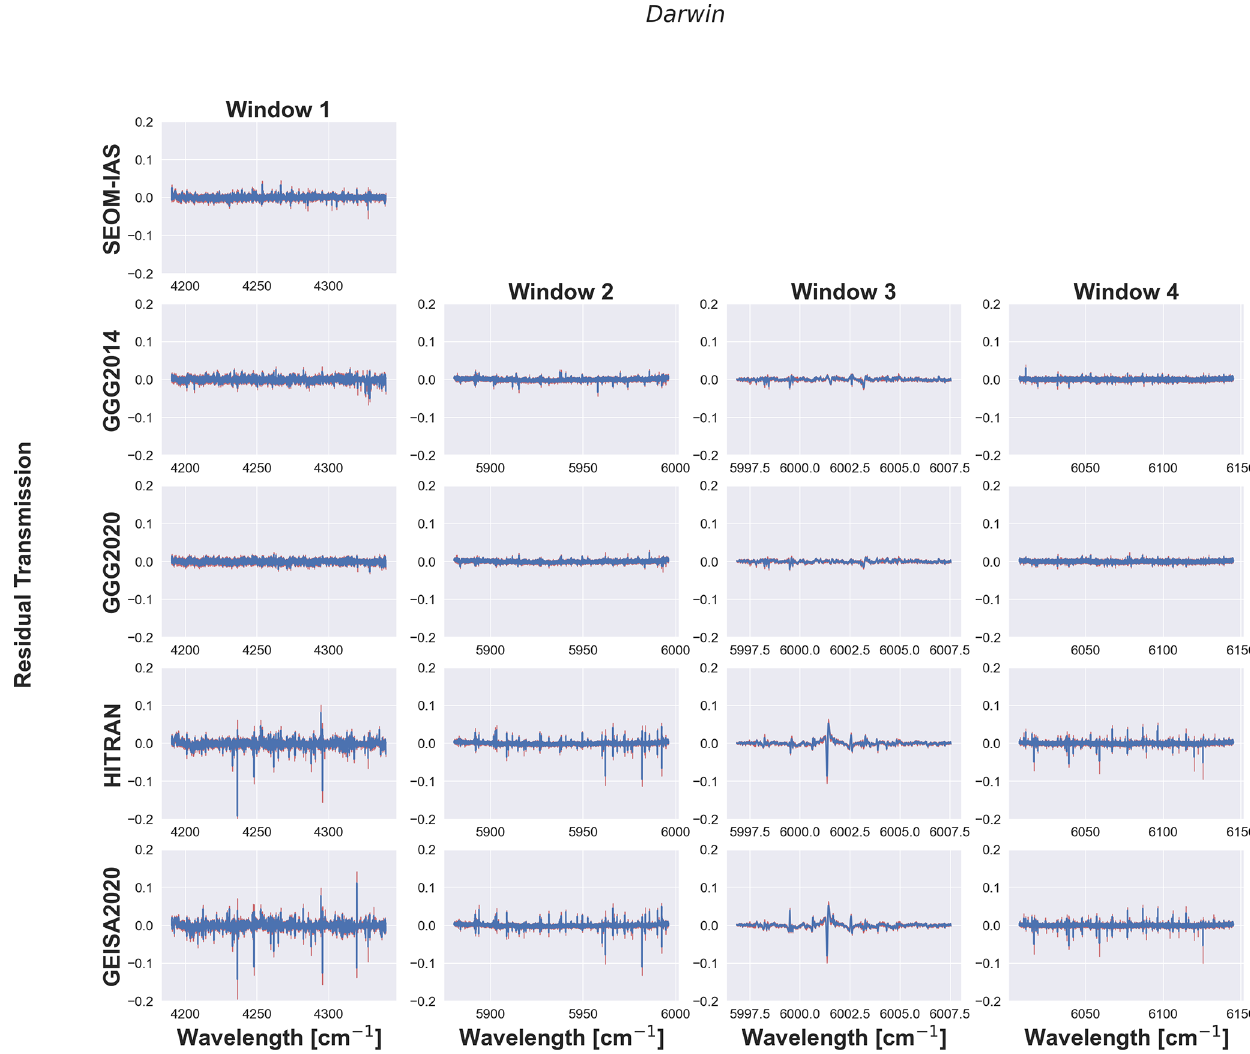
Figure A1. Example residual transmission spectra calculated from measured and fitted spectra from the Darwin site in